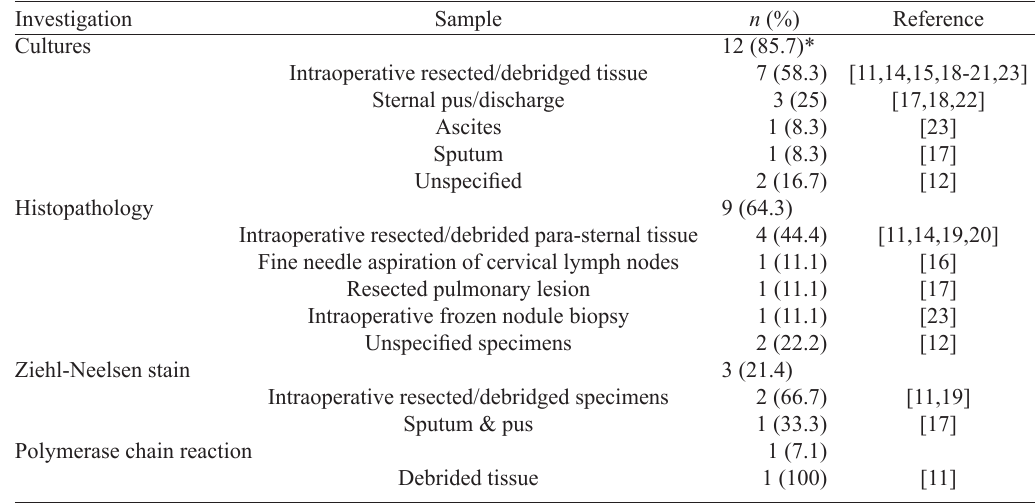
Table 1. Investigations of samples for the diagnosis of sternal wound tuberculosis